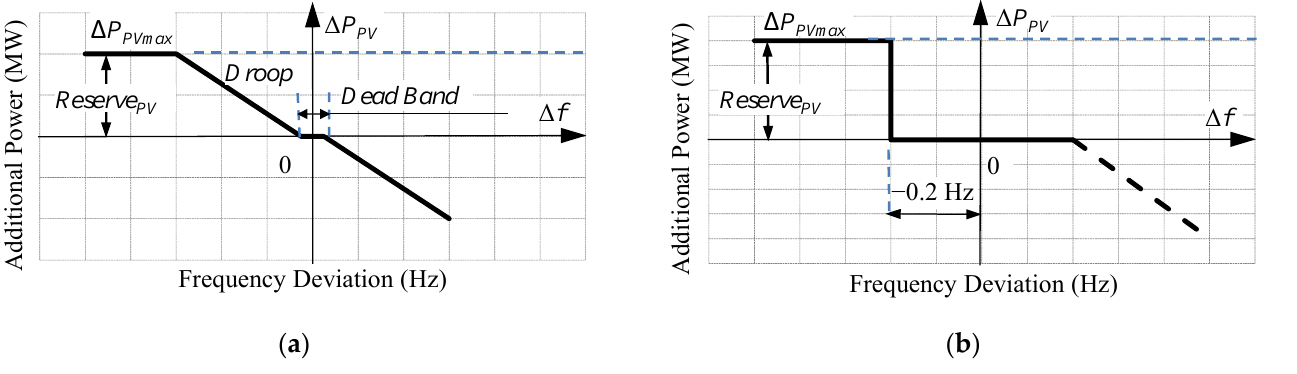
Figure 8. Two types of PV plant frequency response: ( a ) PFR; ( b ) SFR.